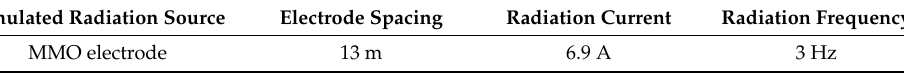
Table 1. Parameter setting table of simulated radiation source.